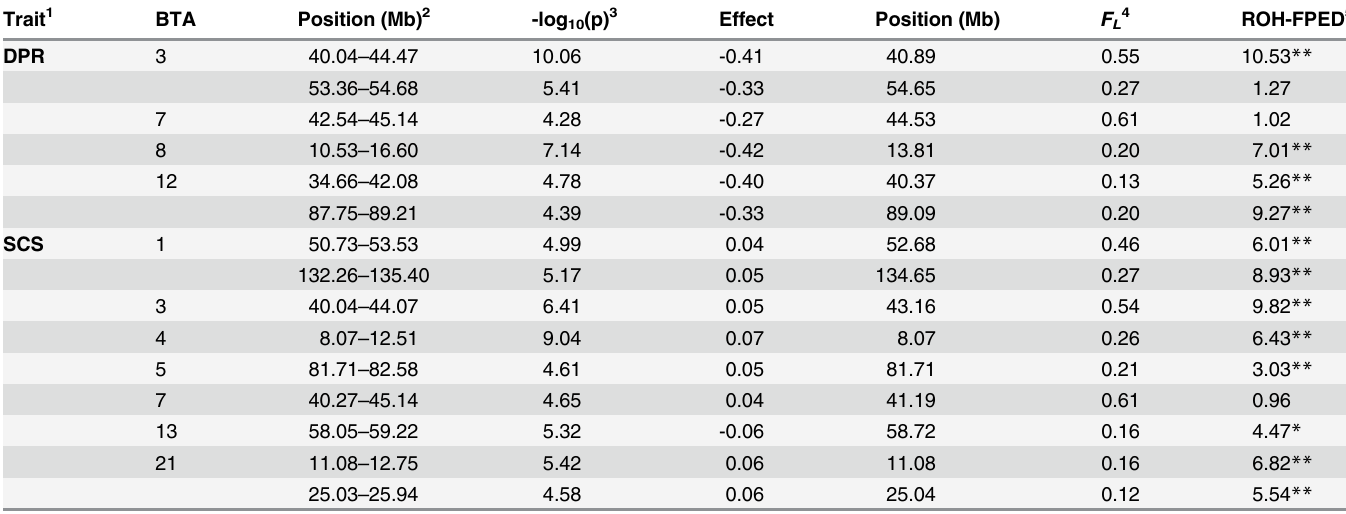
Table 1. Genome-wide association between ROH and DPR or